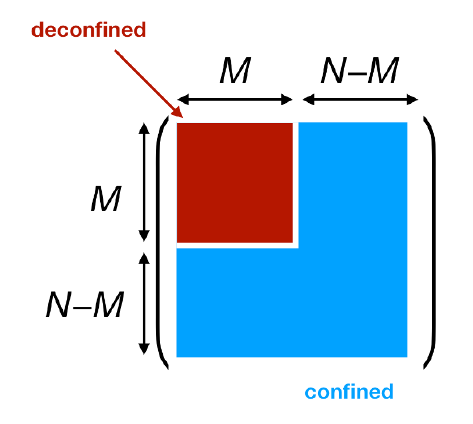
Figure 1 . Partial decon(cid:12)nement in the gauge sector and adjoint matters. Only the M (cid:2) M -block shown in red is excited. The consistency of this cartoon picture with the gauge singlet constraint is discussed around